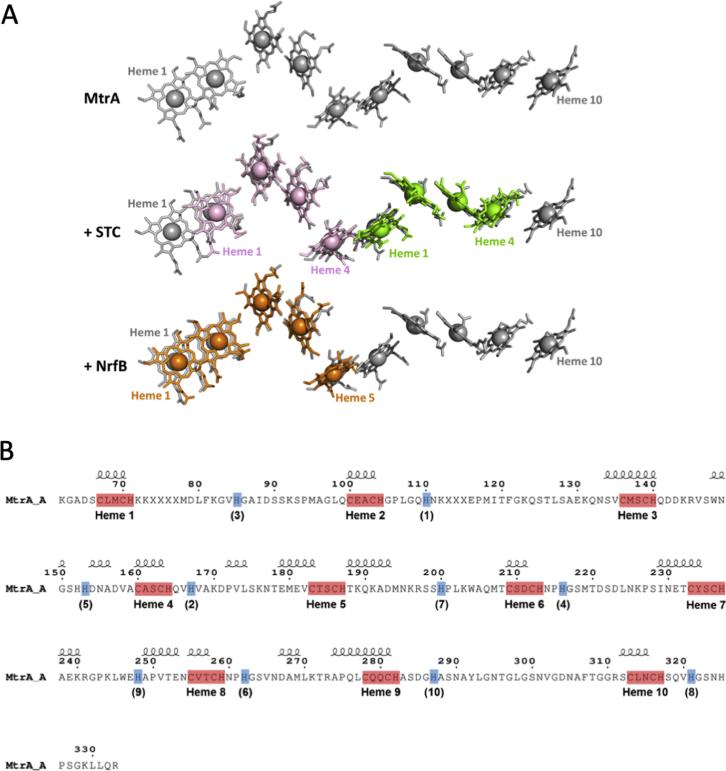
Cofactor Arrangement and Secondary Structure of MtrA, Related to Figure 2(A) Structural alignment of hemes from S.baltica OS185 MtrA (gray) with hemes from two copies of S.oneidensis MR1 STC (PDB: 1M1P, pink/green, RMSD: 1.52 Å/1.64 Å) and hemes from a single copy of Escherichia coli K-12 NrfB (PDB: 2OZY, orange, RMSD: 1.74 Å). Structural alignments were performed using Superpose (Krissinel and Henrick, 2004). (B) MtrA residues visible in the crystal structure of MtrCAB. Disordered residues are indicated by an X. Heme binding residues (CxxCH) are highlighted in red. Distal histidines are highlighted in blue with corresponding heme number shown in parentheses. Secondary structure elements are represented above the amino acid sequence. Figure was modified from the output of ENDscript 2.0 (Robert and Gouet, 2014).